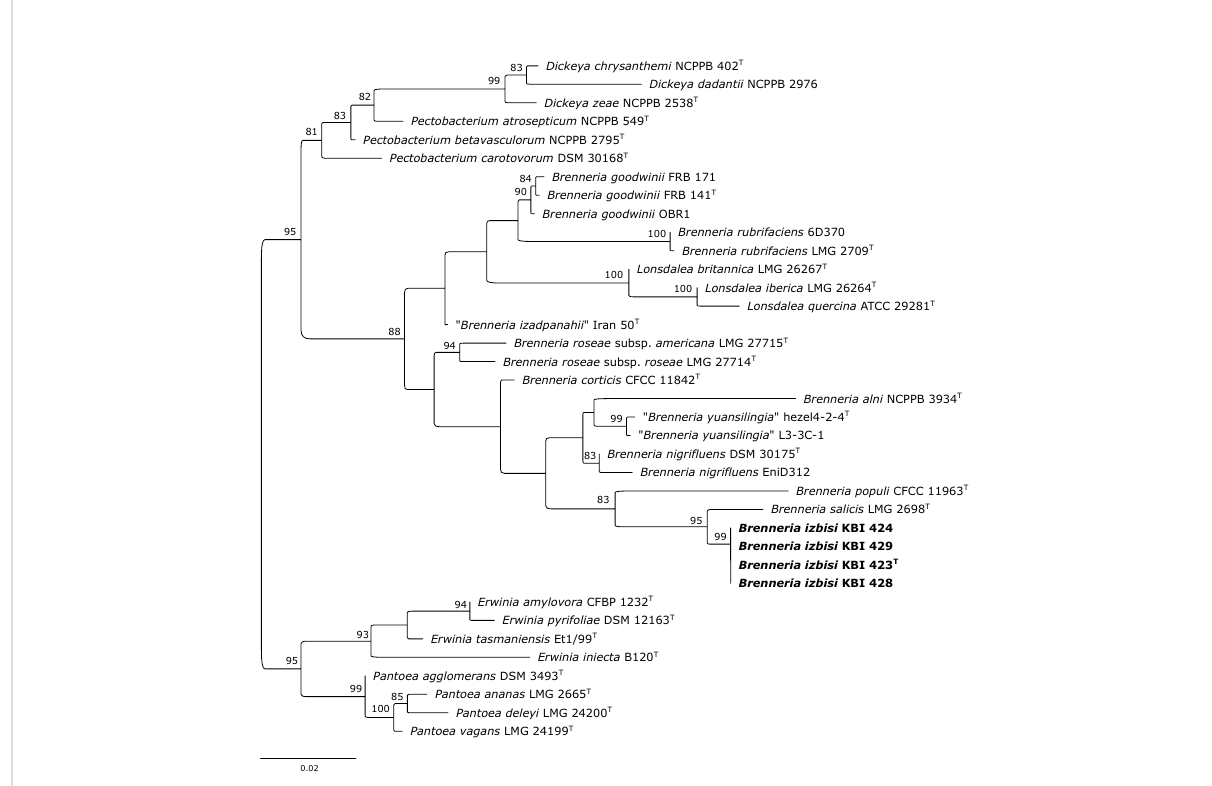
FIGURE 3 Maximum likelihood phylogenetic tree based on 16S rRNA gene sequence. Four representative B. izbisi strains isolated in this study are marked in bold. The best fi tting model HKY+F+I+G4 was applied for tree construction. Ultrafast bootstrap support values (>70) are indicated at the nodes. Reference Erwinia spp. and Pantoea spp. were used as an outgroup to root the